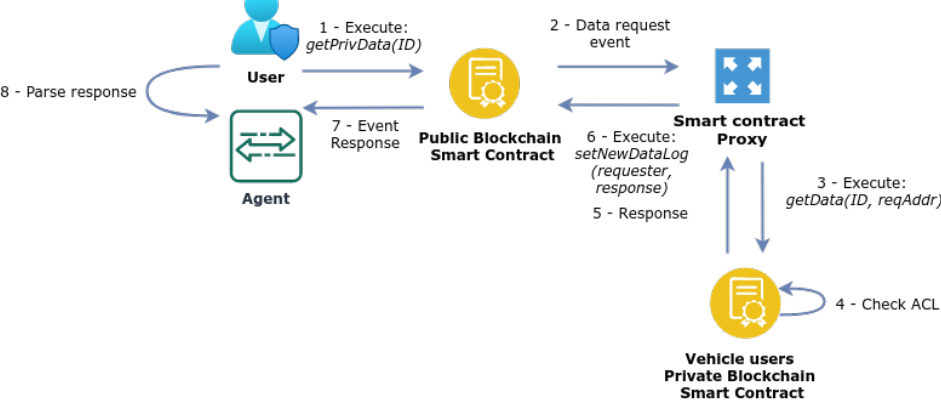
Figure 6. Data access request by an authorised node of the public